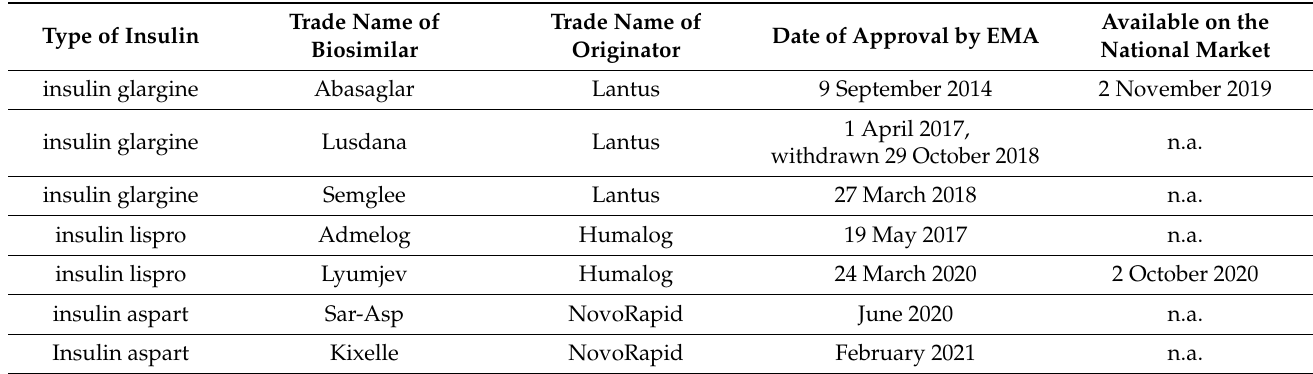
Table 1. Authorized-for-sale by EMA biosimilar insulins (April 2021).